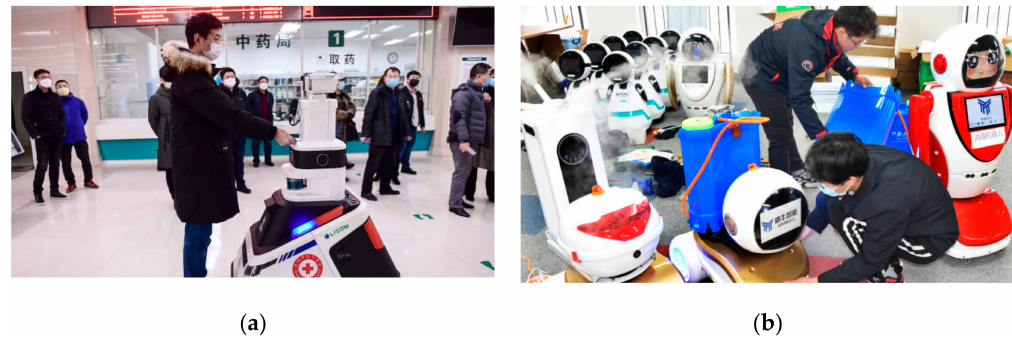
Figure 18. Robots in action during the COVID-19 epidemic in China [82]. ( a ) A patrol robot at a hospital in Shenyang in China’s northeastern Liaoning province checking temperatures of people.